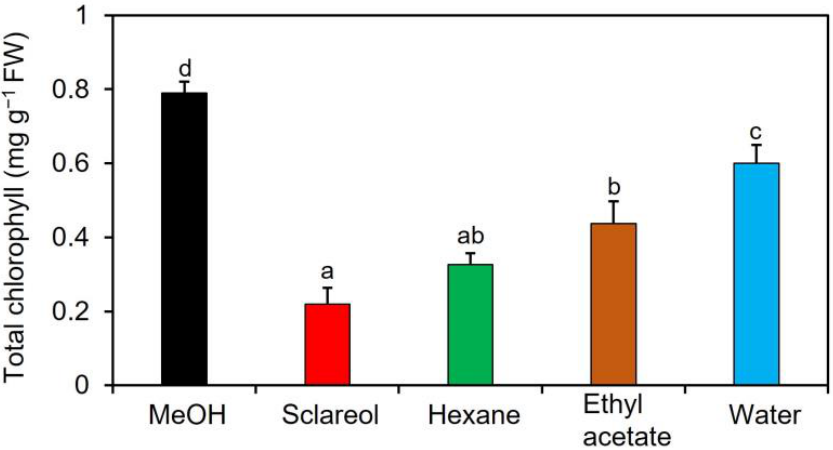
Figure 1. Effects of fractions obtained from an acetone extract of sclareol-treated plants on the accumulation of chlorophyll in Arabidopsis leaves. Sclareol-treated Arabidopsis plants were extracted with acetone. The extract was divided into hexane-, ethyl acetate-, and water-soluble fractions and applied to Arabidopsis plants by soaking their roots in a solution containing each fraction for 48 h. The leaves of the treated plants were collected and the contents of total chlorophyll, represented as the sum of chlorophyll a and b , were measured. As a negative control, 0.1% methanol (MeOH) was used, as previously described in this section. We used 100 µ M sclareol as a positive control. Values are the means ± standard deviation of three biological replicates. Different letters indicate significant differences among treatments (Tukey’s test, p < 0.05).